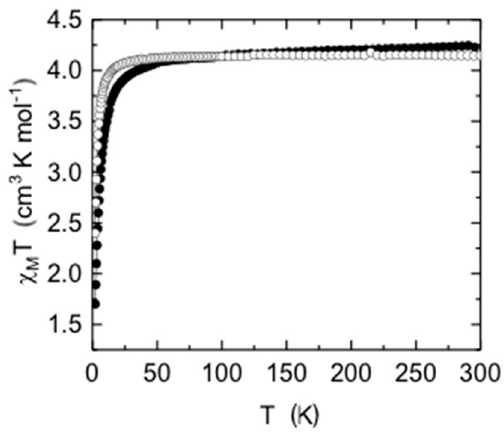
Figure 5. Thermal variation of χ M T between 2 and 300 K for 3 (full circles) and 5 (empty circles).